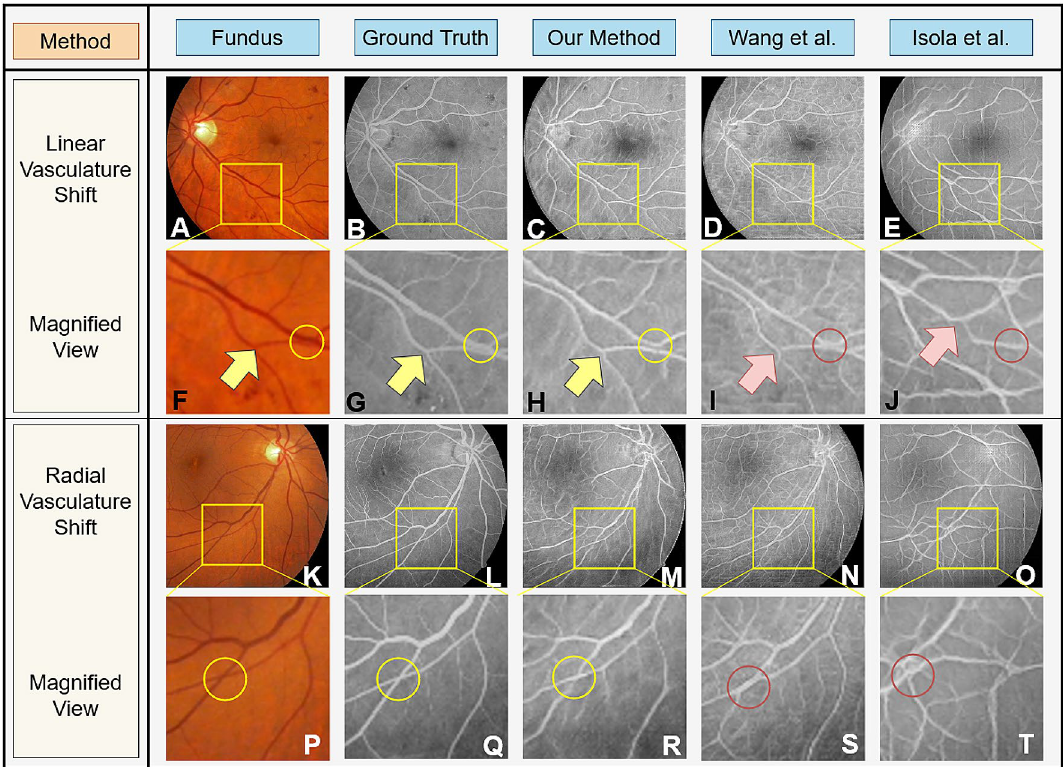
Figure 9. Paired color fundus photograph when vascular structure has small shifts ( A ) or under large vascular movements ( K ) and ground truth FA images ( B,L ). FA images generated by our proposed method ( C ) and those generated by traditional GANs proposed by Wang et al. ( D,N ) 50 and Isola et al. ( E,O ) 27 . Subfigures ( F–J